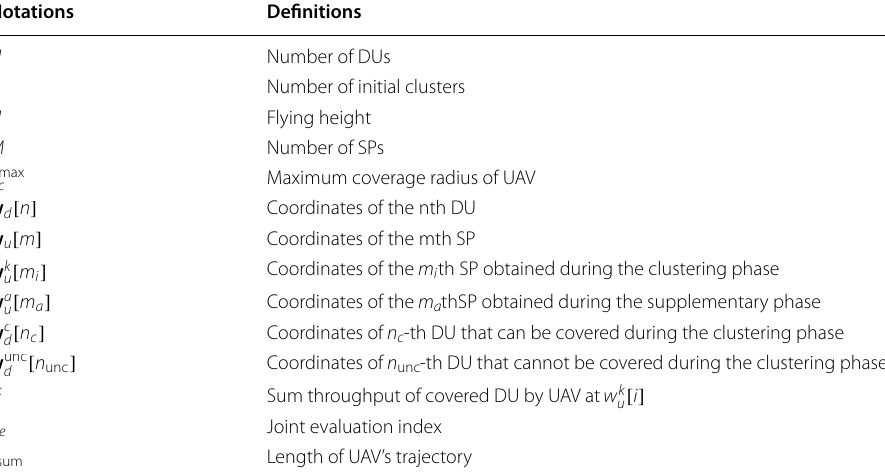
Table 1 Summary of key notations